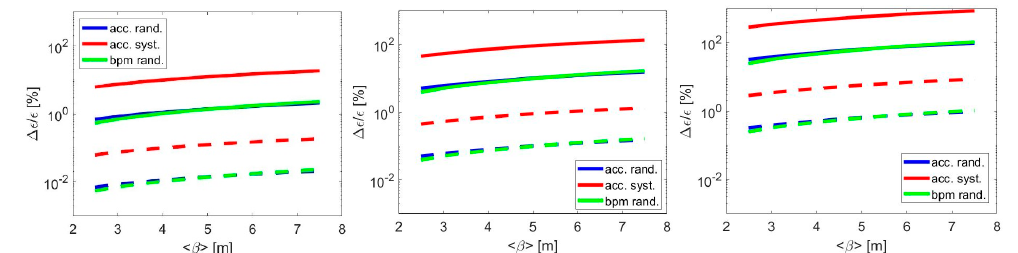
Figure 6. Percent projected emittance growth due to BBU through the linac downstream BC2 as function of the random rms misalignment of accelerating structures and average betatron function, for the bunch charge of (from left to right) 75, 150, and 300 pC. Beam and linac parameters are in Tables 3 and 5. The red dots and labels refer to PLACET results. Note the color scale spans over 2 orders of magnitude from low to high charge.